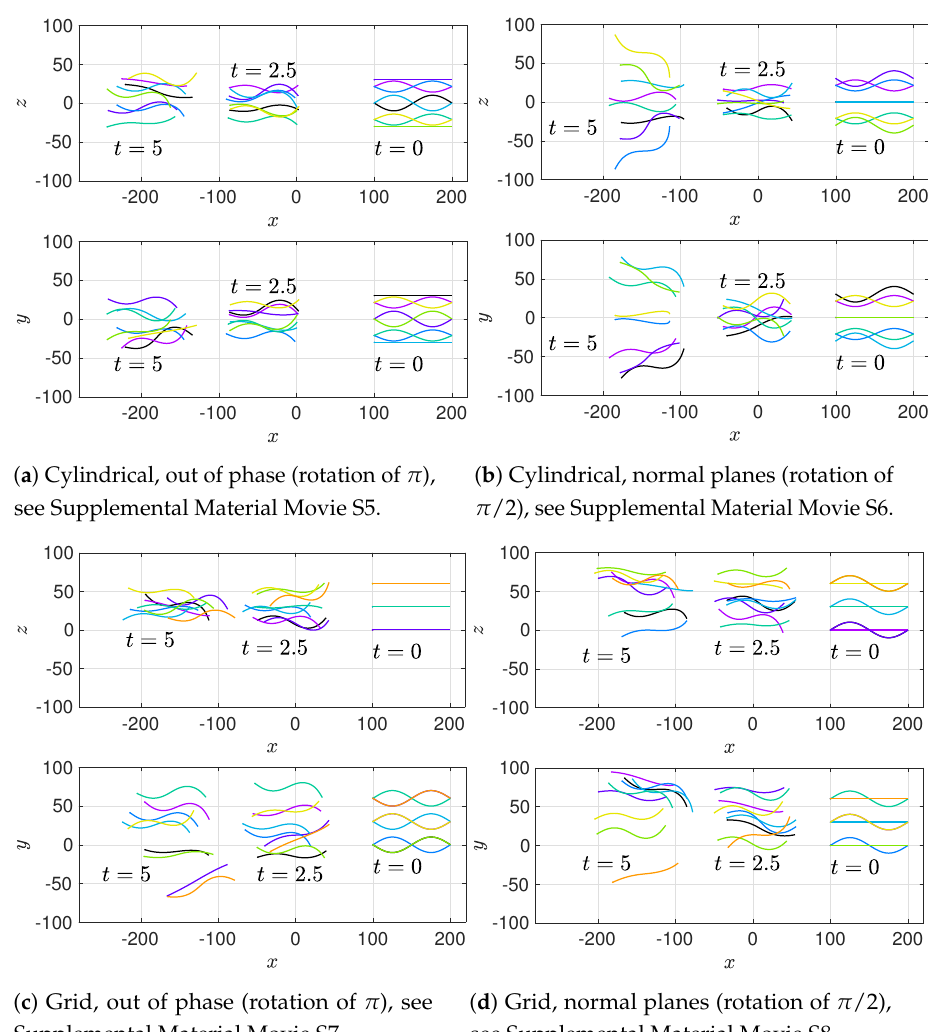
Figure 14. Phase/alignment differences between nearby neighbors. Snapshots of locations of flagella over time in 2D, overlaid. Times shown are every 2.5 s or 25 beats, as labeled in panels. Head positions started near x = 100 µ m (see Figure 6a–c) and flagella move in the negative x -direction. All units are in µ m. Color of curves indicates data for flagellum of matching color from initial configurations (see Figure